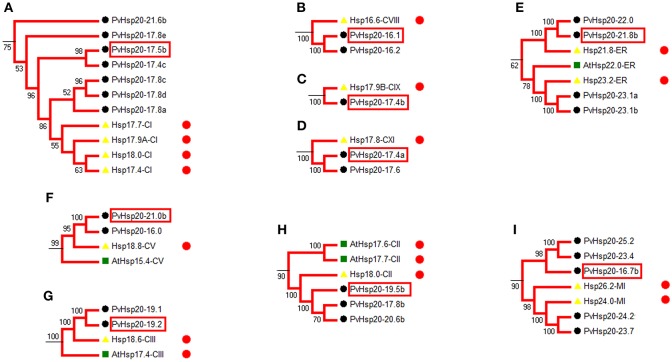
Phylogenetic relationships show the PvHsp20s that are orthologous to annotated stress-responsive Hsp20 genes in rice and Arabidopsis. 28 PvHsp20 proteins were predicted to be involved in stress tolerance, and they were divided into nine functional groups (A–I). The red circles indicate proteins with stress-related functional annotation (Table S2), and proteins marked with red frames were used to be validated in further qRT-PCR. Rice, Arabidopsis, and switchgrass are Hsp20 proteins marked with yellow triangles, green squares, and black circles, respectively.